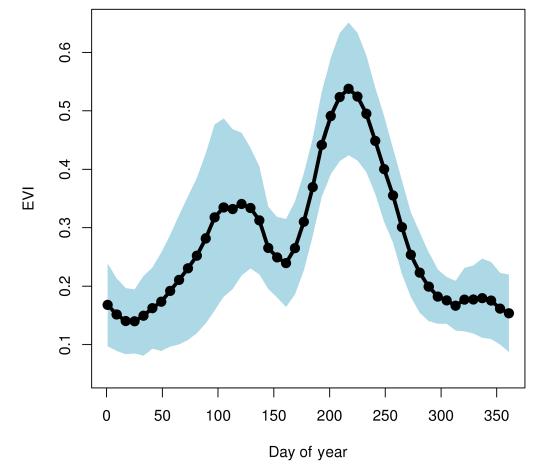
Figure 2. Average EVI in IGBP cropland class from 32 to 38 ◦ N. Bimodal peak represents (1) winter wheat spring emergence and (2) corn summer emergence. Shaded blue region represents 1 σ of spatial and temporal